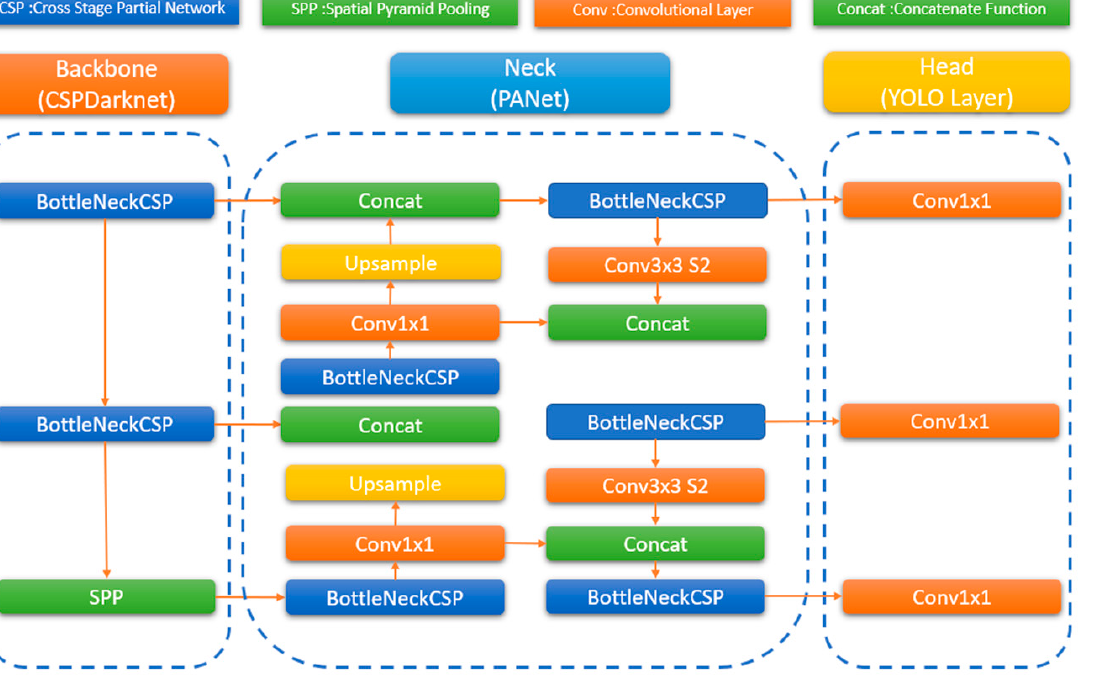
Figure 1. YOLO V5 architecture.